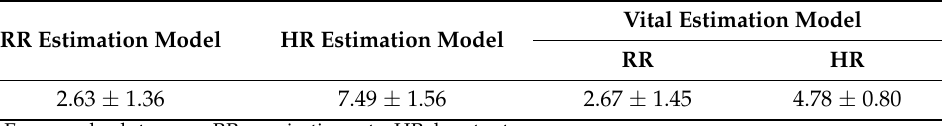
Table 4. Vital signs detection results of RR, HR, and vital estimation model on the test dataset (mean ± STD of